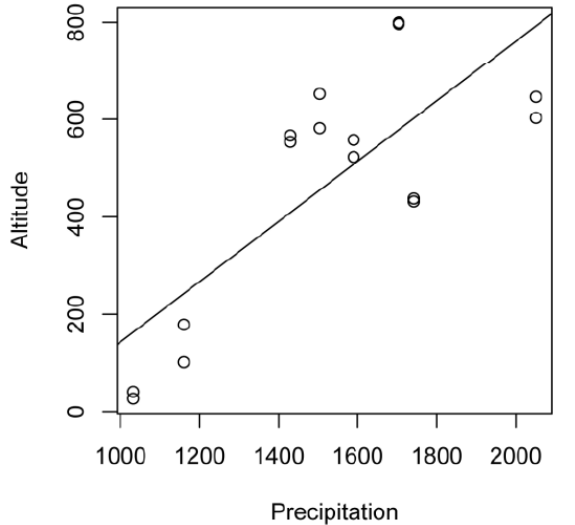
Figure S1. Correlation between precipitation and altitude of the 16 plots of the study area (F = 21.47, P = 0.0004, r 2 = 1,14